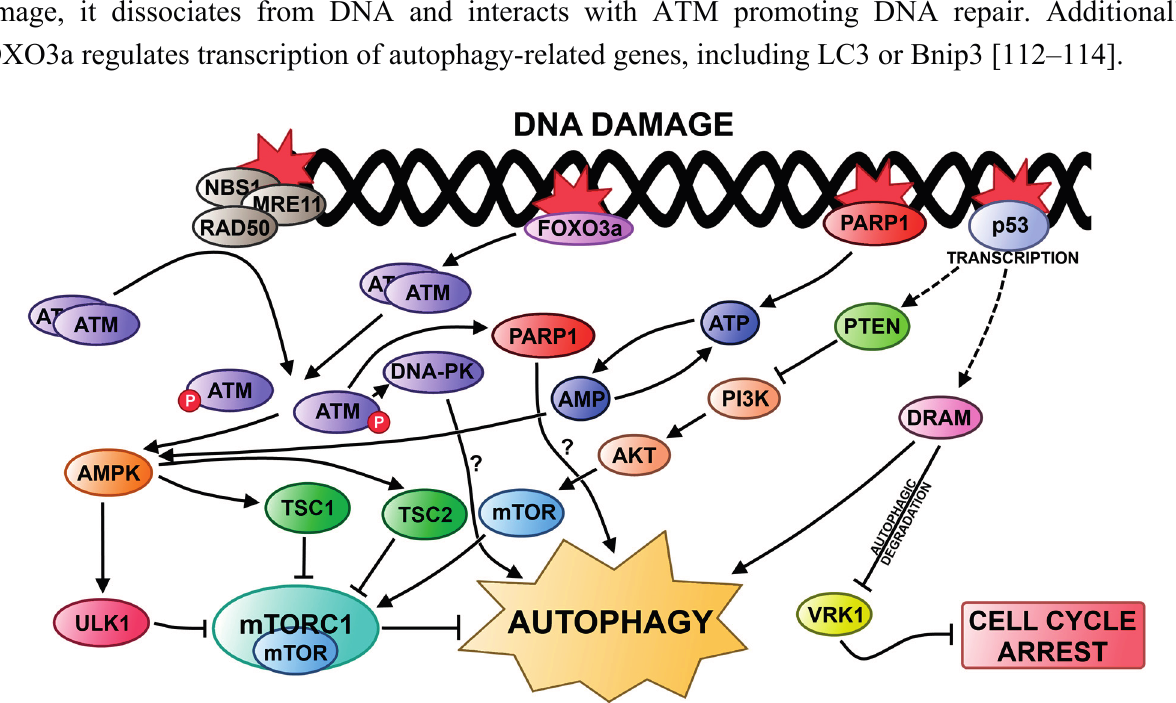
Figure 2. Autophagy in the DNA damage response. Activation of autophagy in response to DNA damage is mainly achieved by inhibition of the mTOR complex 1 (mTORC1), which is a negative regulator of autophagy. p53 acts as a transcription factor, and if there is DNA damage it can upregulate expression of proteins inducing autophagy. One of them, DRAM (damage-regulated autophagy modulator), is responsible for autophagy degradation of VRK1 (vaccina-related kinase 1), a protein involved in cell cycle checkpoint activation, thus it arrests the cell